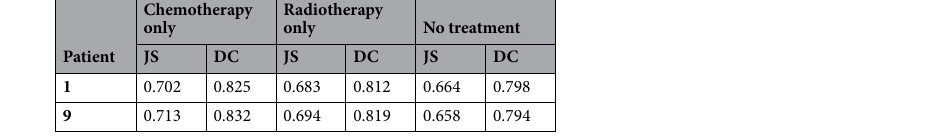
Table 3. Evaluation results of the proposed method on the 2 patients with both treatments by ignoring one or two treatments.